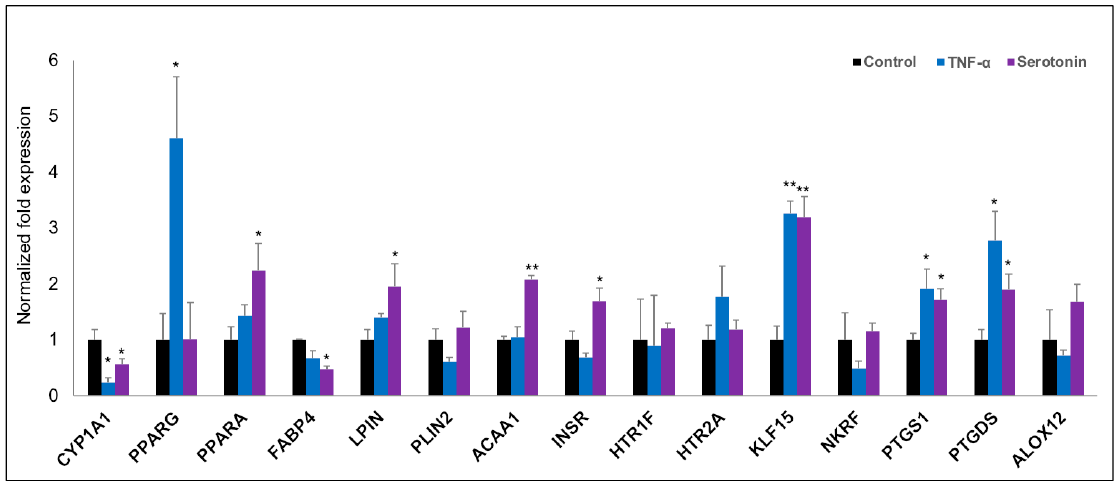
Figure 6. RT-qPCR validation of expression changes of selected metabolism-related genes in porcine mature adipocytes (pMA) of intramuscular origin. The pMA (2.5 × 10 4 cm 2 ) were stimulated with serotonin (100 µ M) and TNF- α (2.5 µ g / mL) both for 12 h. The normalized fold expression of each gene obtained from three independent experiments and represented in each bar as mean ± standard deviation. The asterisks (*, p < 0.05; **, p < 0.01) indicate statistically significant difference when compared with control.